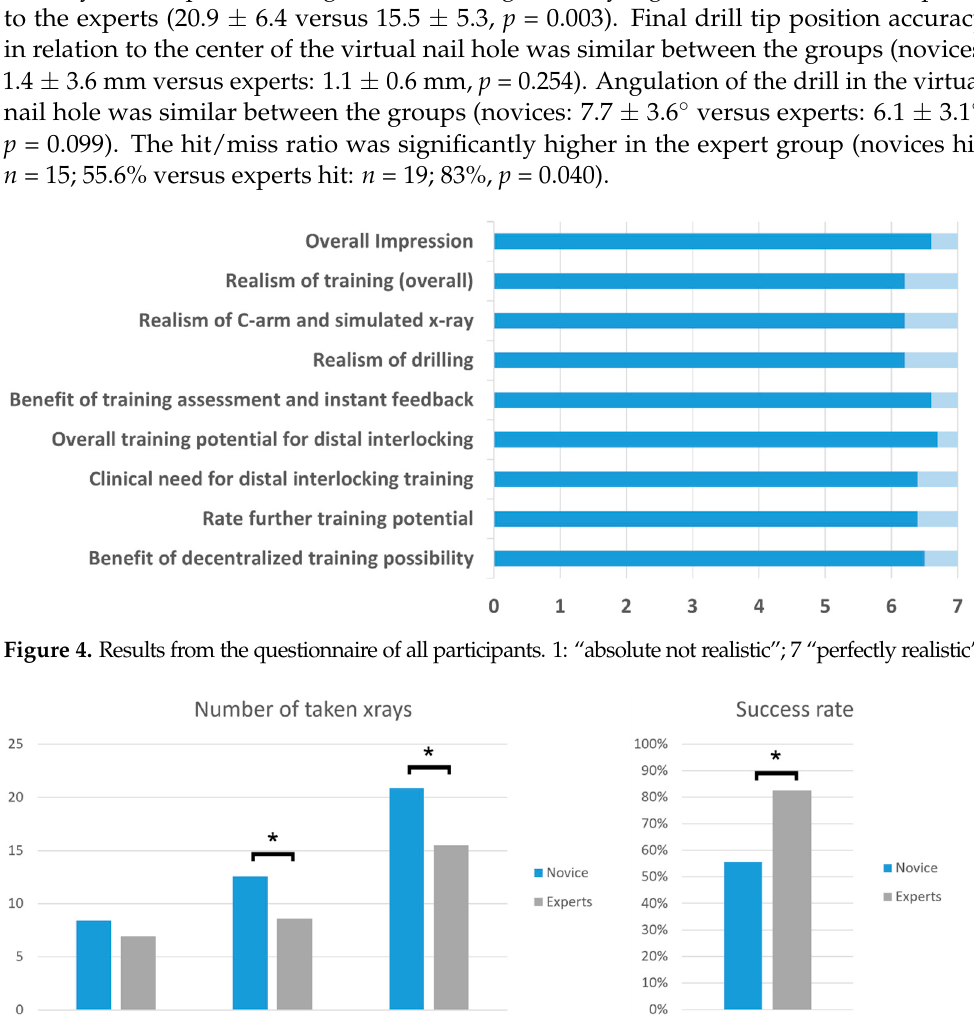
Figure 5. Comparison of novice (blue) and expert (grey) performance based on the captured metrics. Numbers of taken X-rays ( left ) and success rate (hit/miss ratio) ( right ). Stars indicate significant differences between the groups.